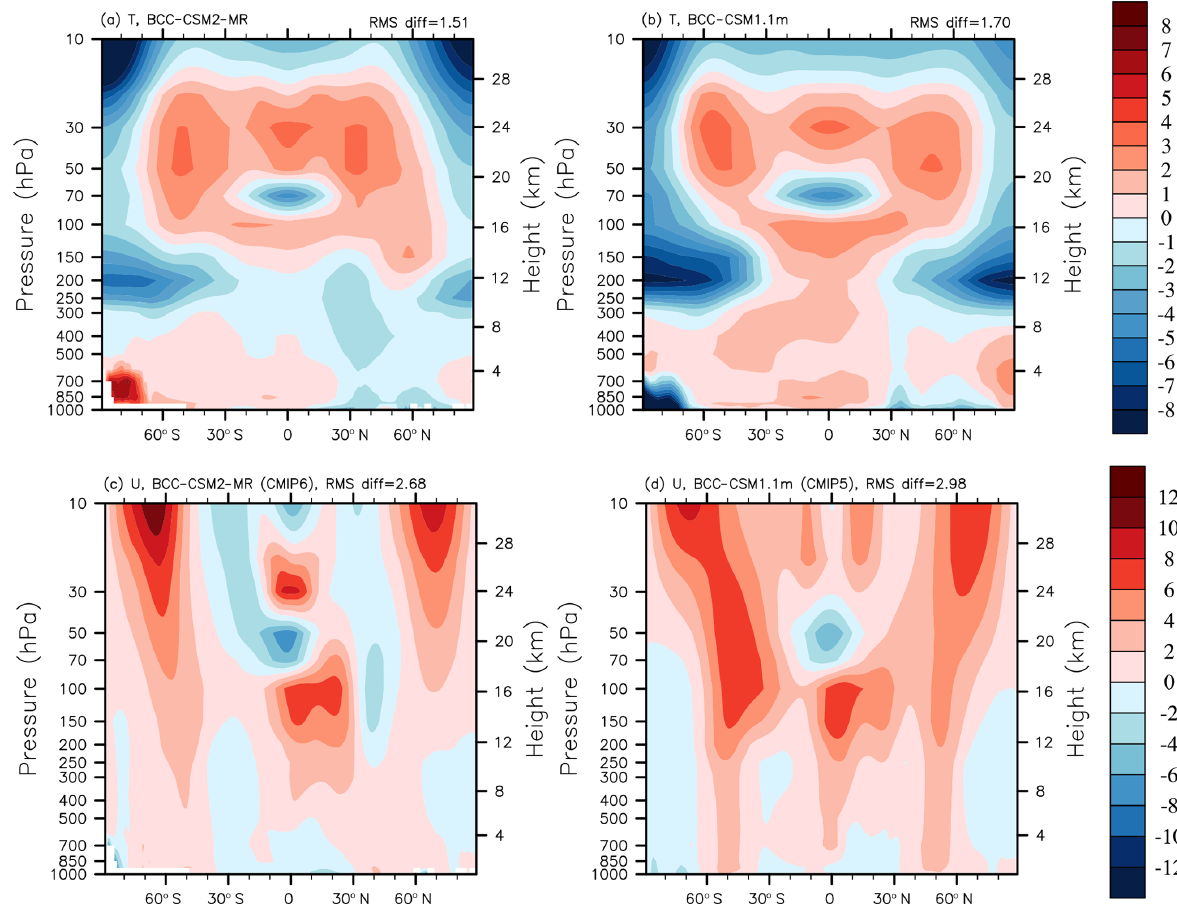
Figure 9. Pressure–latitude sections of (a, b) annual mean temperature biases (in Kelvin) and (c, d) zonal wind biases (ms − 1 ) for BCC- CSM2-MR (a, c) and BCC-CSM1.1m (b, d) , with respect to the ERA-Interim reanalysis data for the period from 1986 to